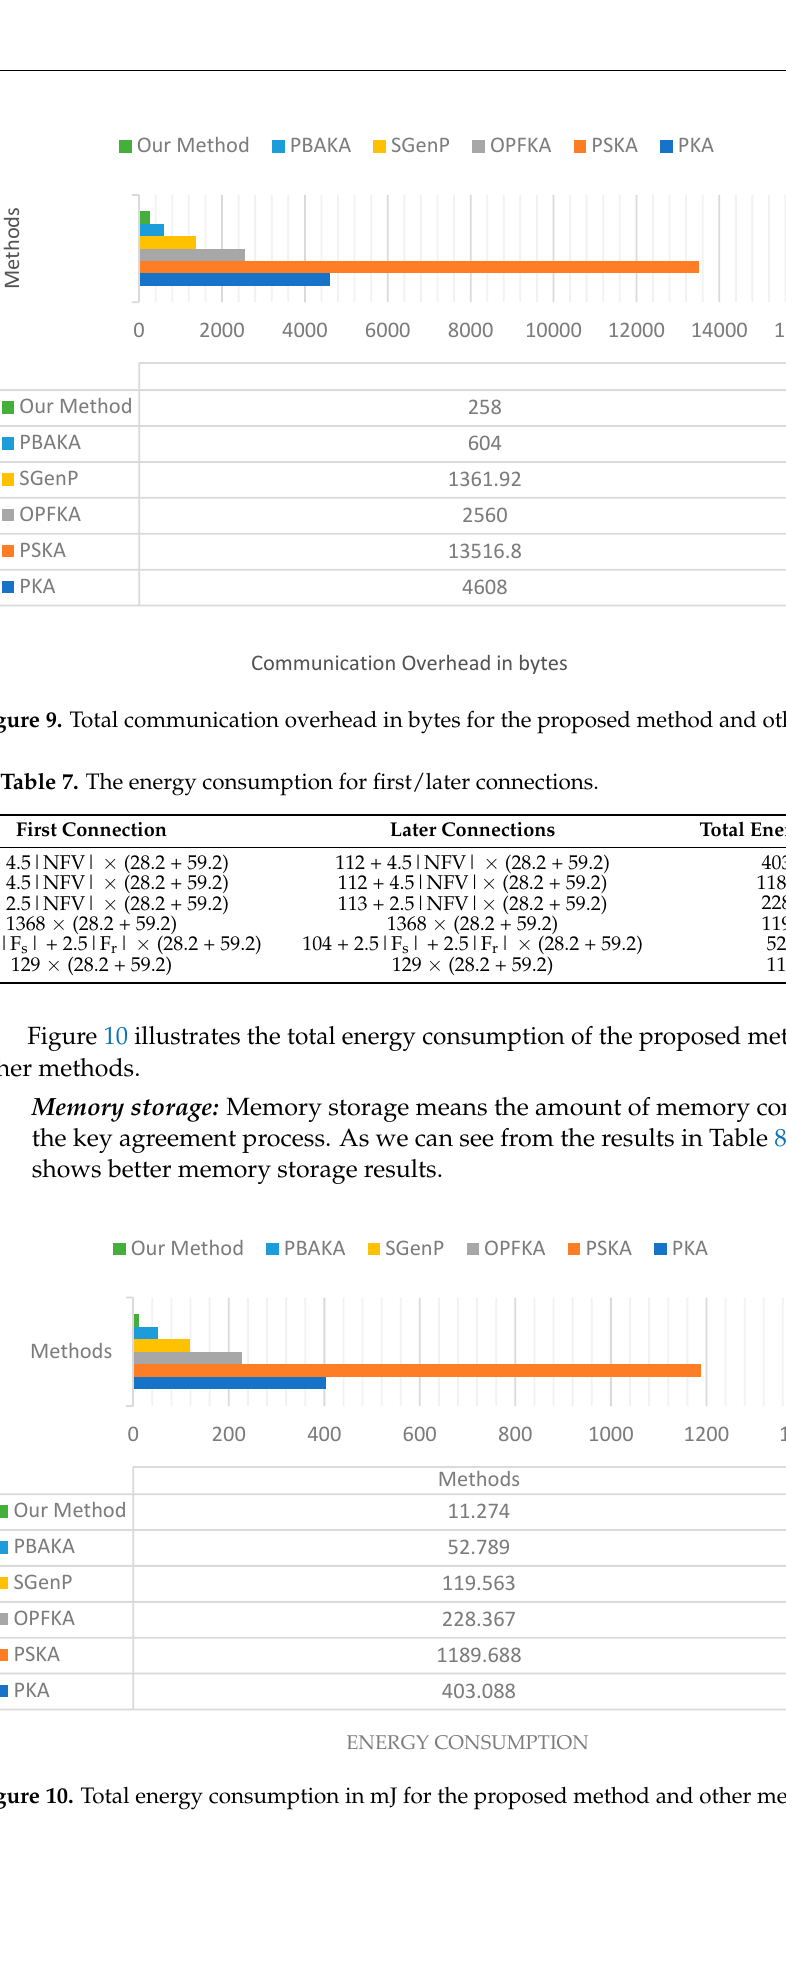
Table 8. Memory cost for first/later connections.